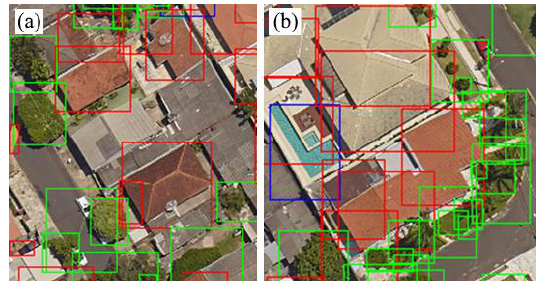
Figure 5 - Object detection for 2 regions. Legend: buildings (red), trees (green), swimming pool (blue).